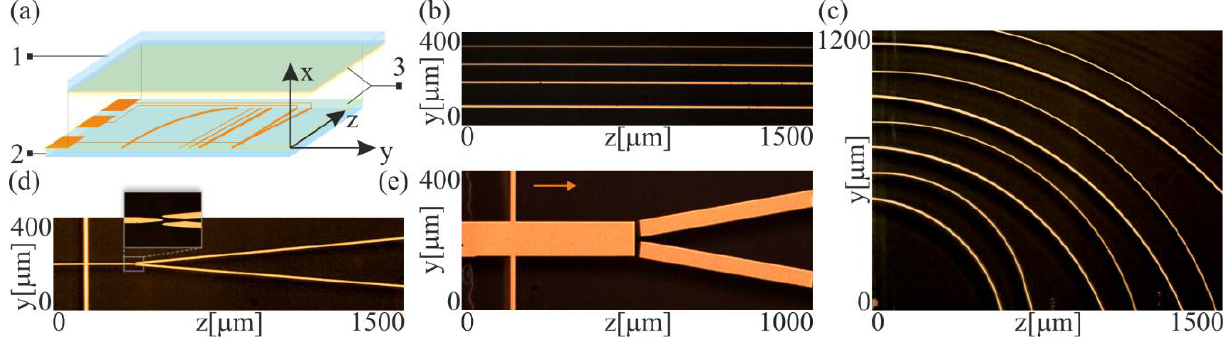
Figure 1. Electrically controlled NLC structures: ( a ) sketch of the NLC cell; ( b ) straight and ( c ) curved electrodes (widths 5 μm and 10 μm); ( d ) combination of three independently controlled electrodes for realizing optical Y-junction (10 μm width, one input and two output ports); ( e ) combination of Y-shaped independently controlled electrodes (the widths 100 μm and 50 μm) for the realization of beam switching in nonlinear propagation regime (a nematicon).